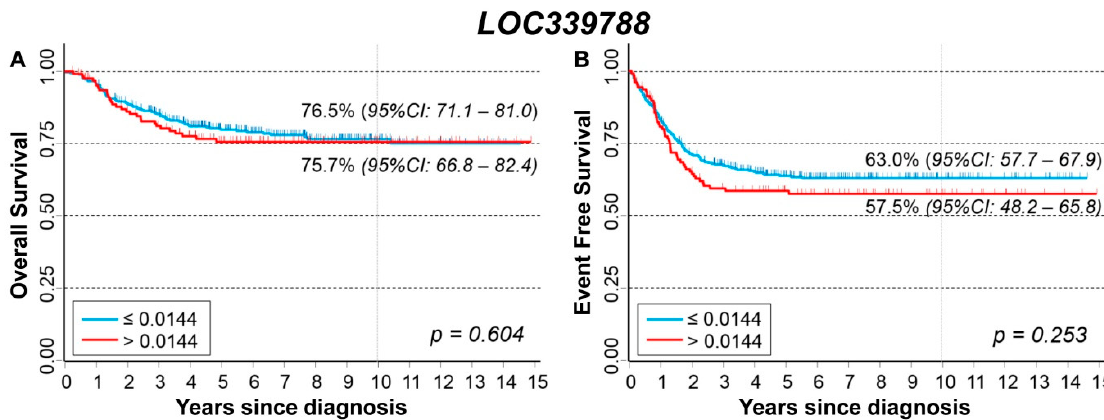
Gene Expression N/E HR 95% CI Figure 14. ( A ) Overall Survival of 498 NB patients in relation to LOC339788 expression levels. The selected cut ‐ off is based on the baseline expression value. ( B ) Event Free Survival of 498 NB patients in relation to LOC339788 expression levels. The selected cut ‐ off is based on the baseline expression value. Table 15. Overall Survival of 498 NB patients in relation to LOC339788 expression levels evaluated by the Cox model.